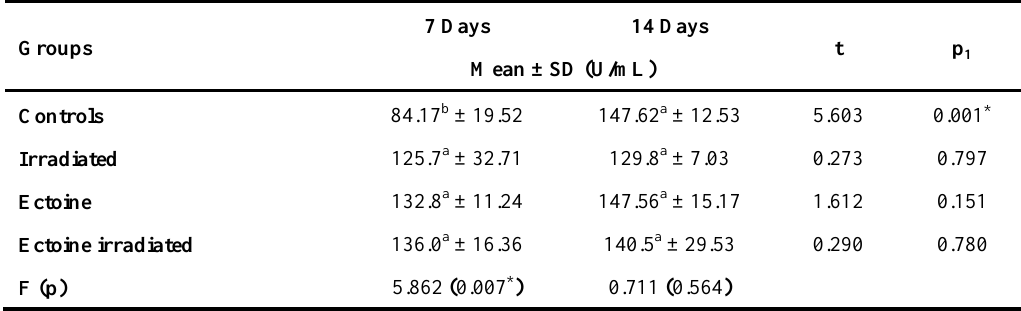
Table 3. The effect of ectoine on serum Total Antioxidant Capacity (T. AOC) in the model of irradiation- induced cardiotoxicity in female albino mice